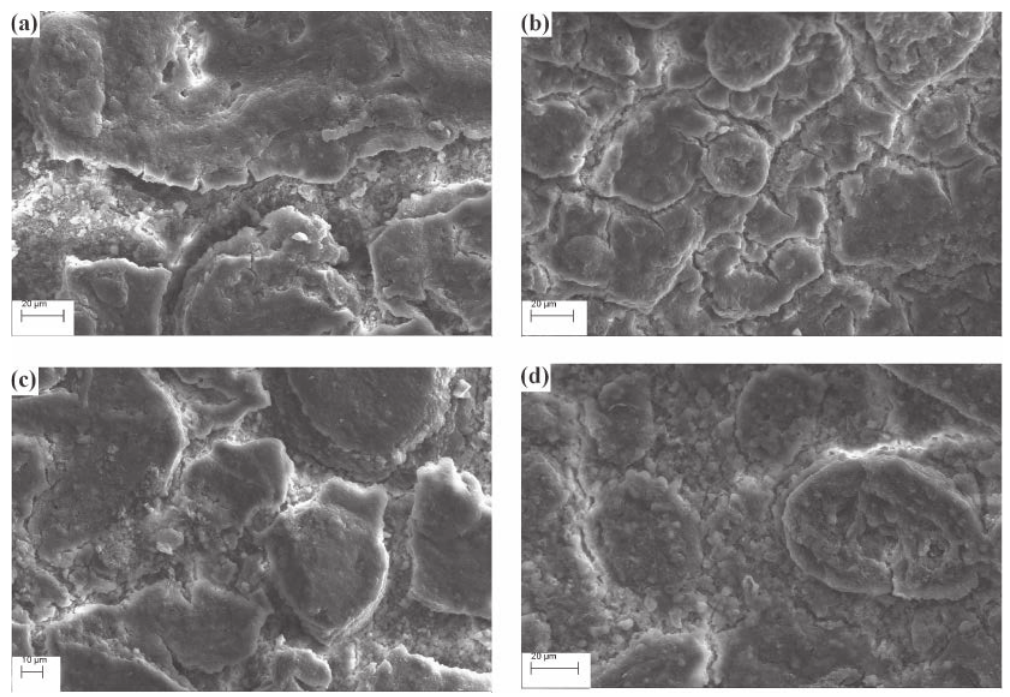
Fig. 6: SEM of the cross sections of the h -BN under different H 2 O/air mass ratio conditions: (a) 1.5:100, (b) 3.5:100, (c) 5:100, (d)